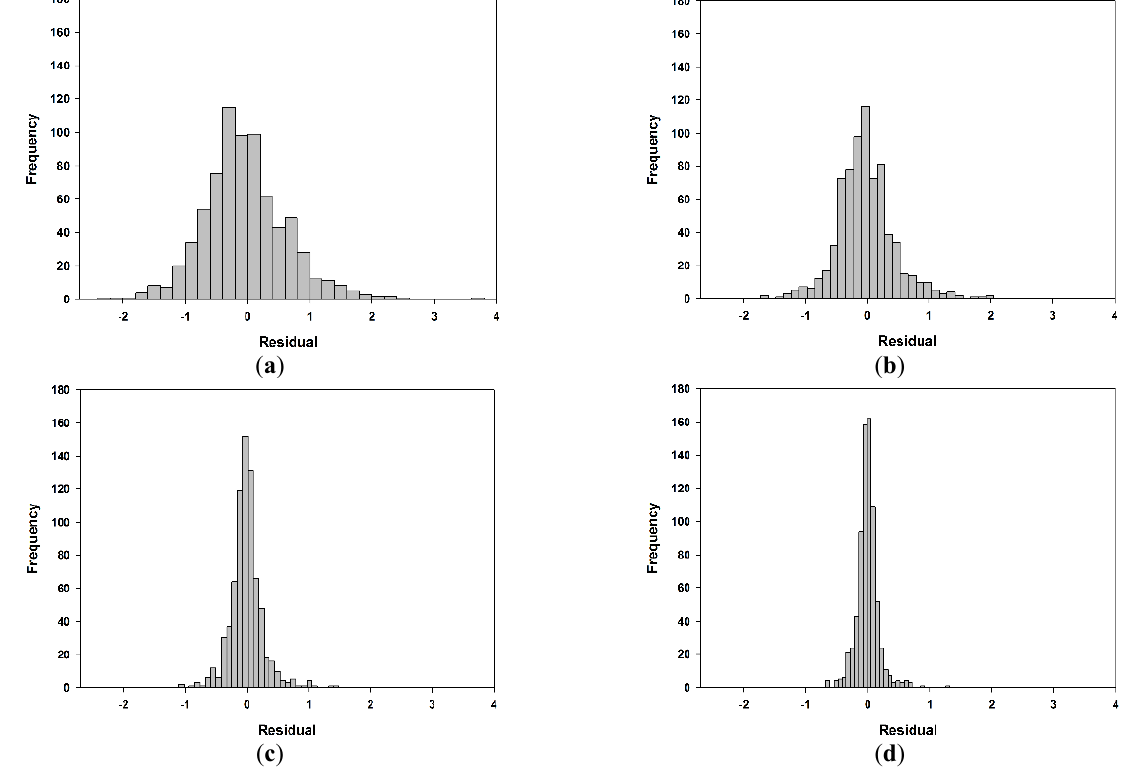
Figure 8. Histogram of residuals of Al Ghazalah City as a best-fitted model for data series of standardized precipitation evapotranspiration index SPEI at different time scales during the period of 1950–2010: ( a ) 3-SPEI, ( b ) 6-SPEI, ( c ) 12-SPEI and ( d )